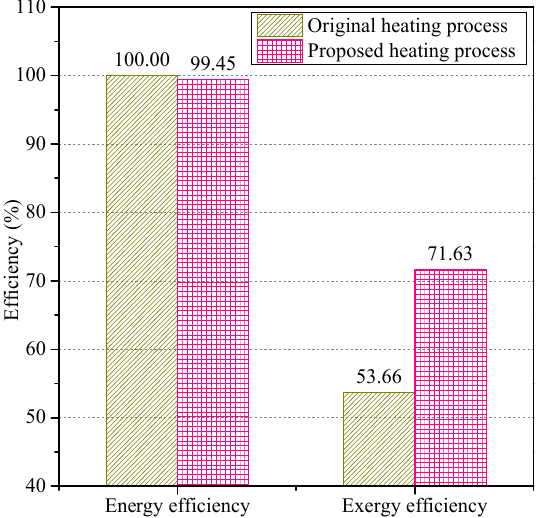
Figure 8. Energy and exergy efficiencies of the original and proposed heating processes.